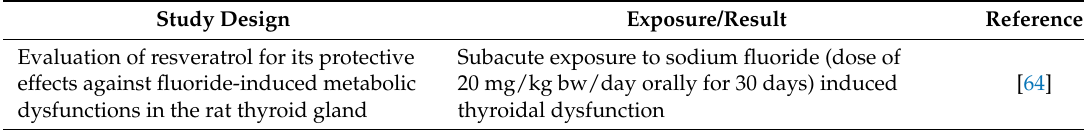
Table 1. Studies that document interactions of thyroid hormones with